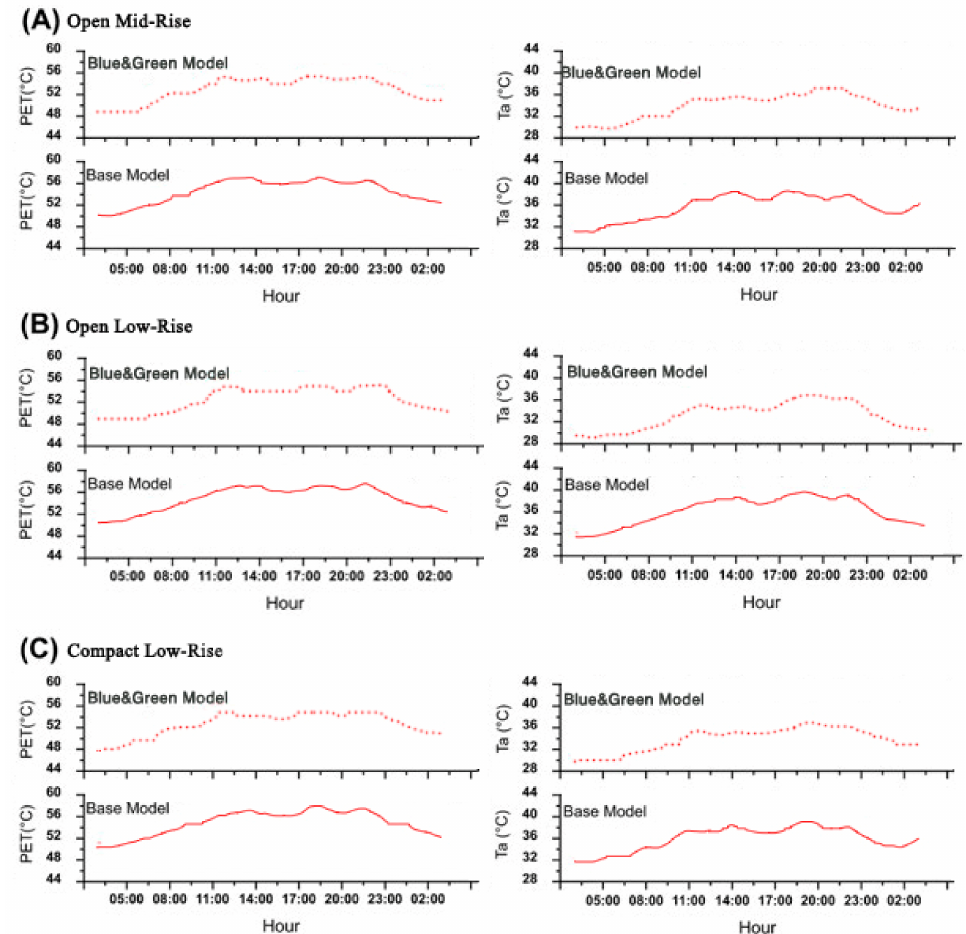
Figure 15. Variations of Ta and PET in each